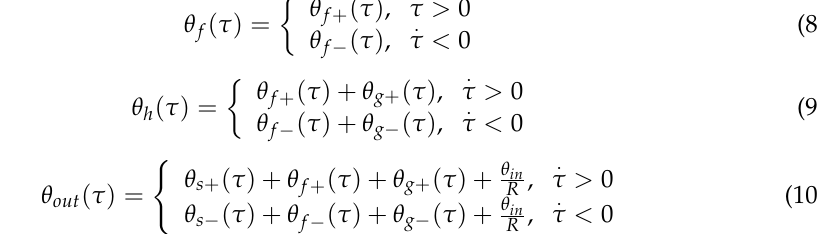
When considering the influence of the torque change rate on hysteresis, θ out ( τ ) can be expressed as the θ out curve as shown in Figure 6, and Equation (10) can be expressed as Equation (11).